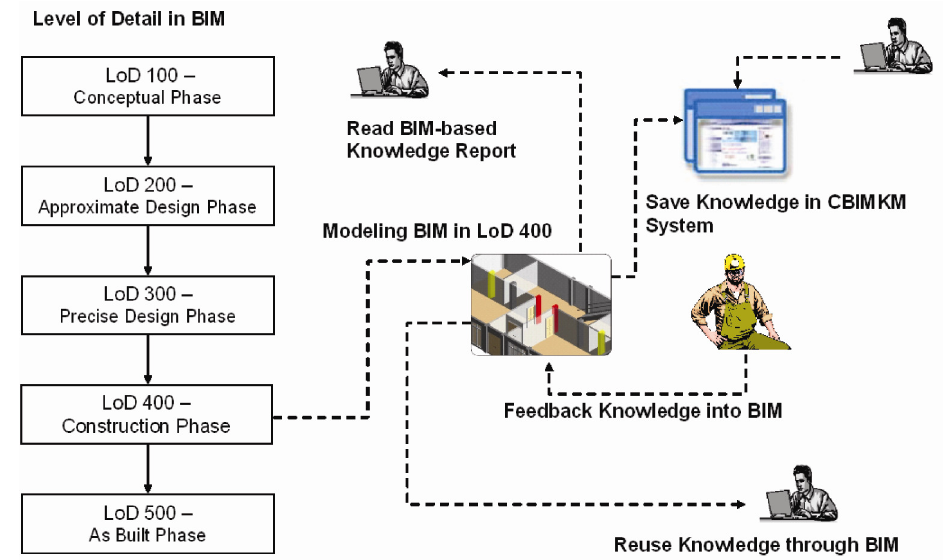
Fig. 1. The application of the BIM approach in construction knowledge